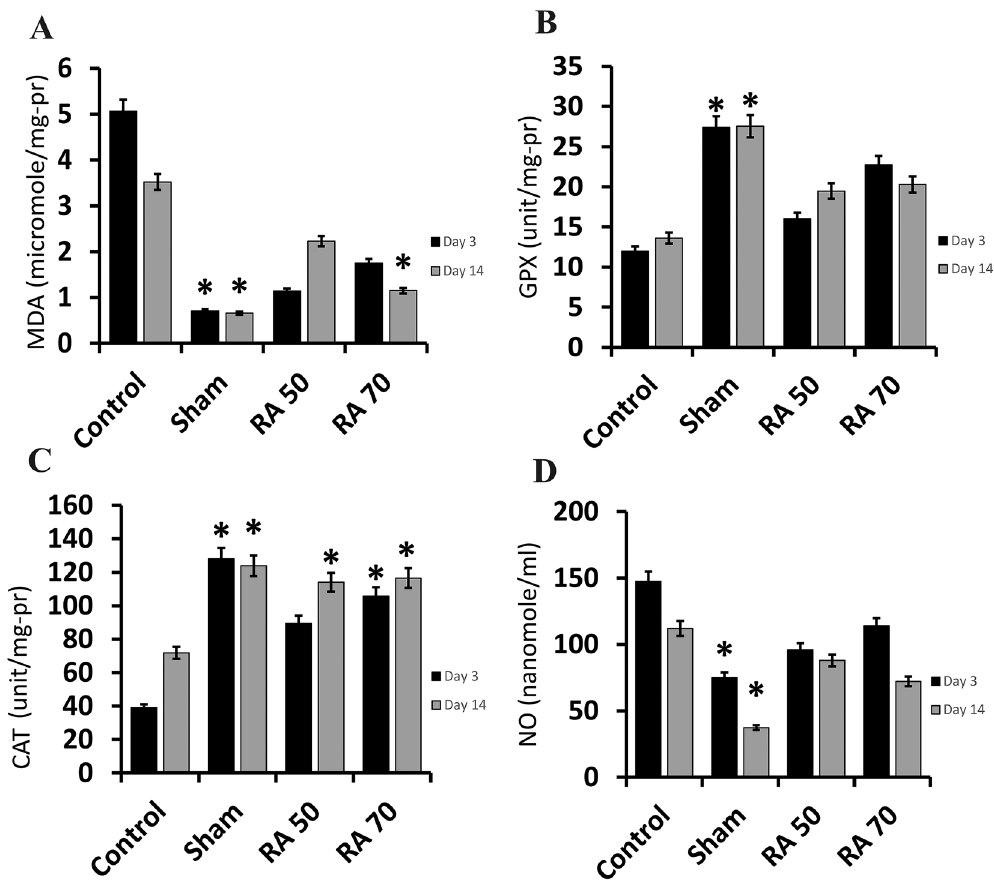
Figure 5. Oxidative stress biomarkers in various experimental groups of the study on days 3 and 14. ( A ) Malondialdehyde (MDA); ( B ) Glutathione peroxidase (GPx); ( C ) catalase (CAT); ( D ) Nitric oxide (NO). * Indicates significant difference with the control group.